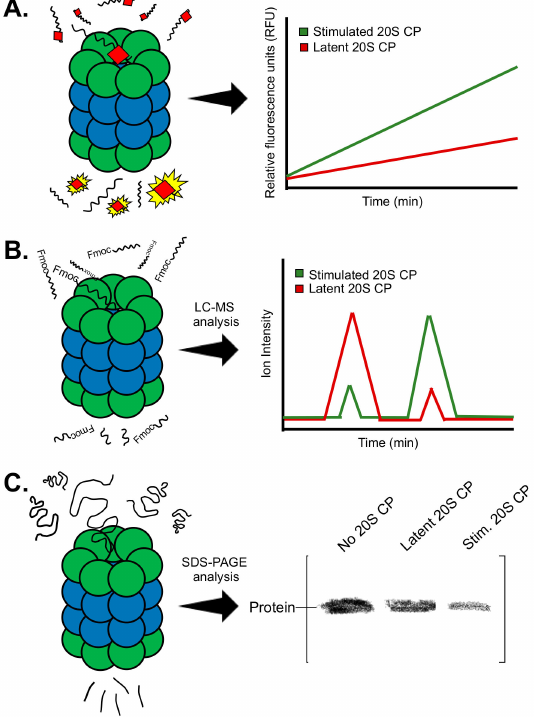
Figure 2. Summary of the biochemical methods often used to identify proteasome